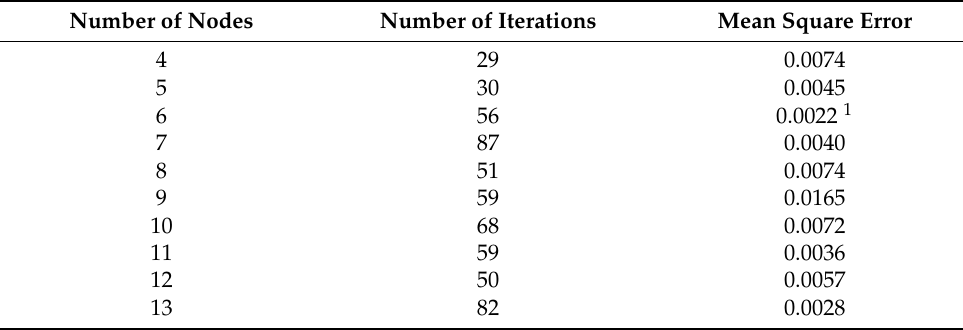
Table 1. The results of the hidden layer node model training.